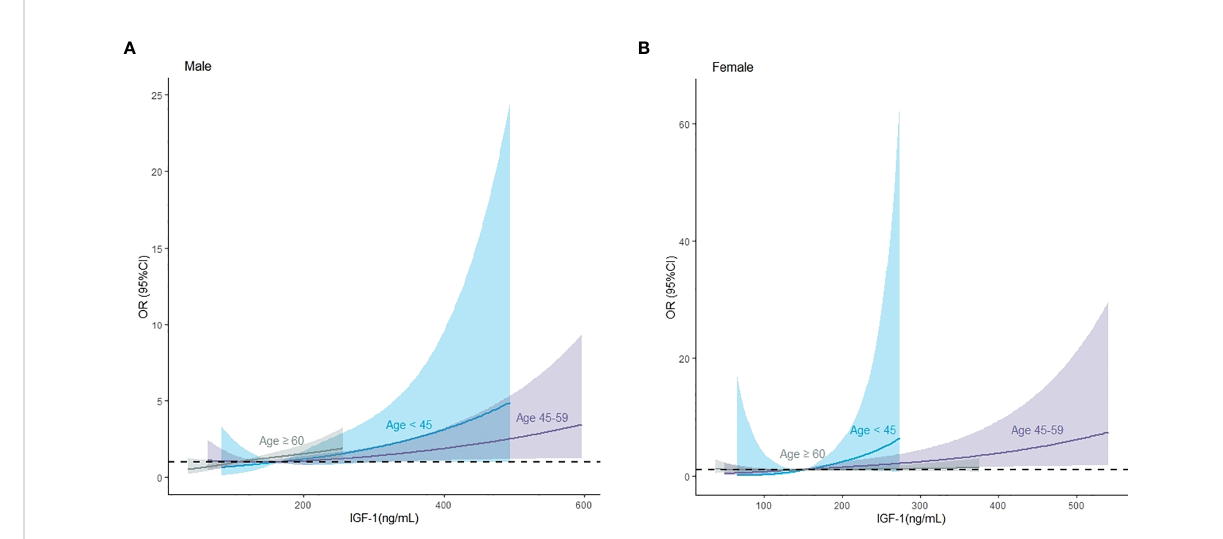
FIGURE 4 The association between insulin-like growth factor-1 and interventricular septal thickening according to restricted cubic splines in male and female patients, respectively. (A) Male population, (B) female population. The asterisk means adjusted for propensity scores.